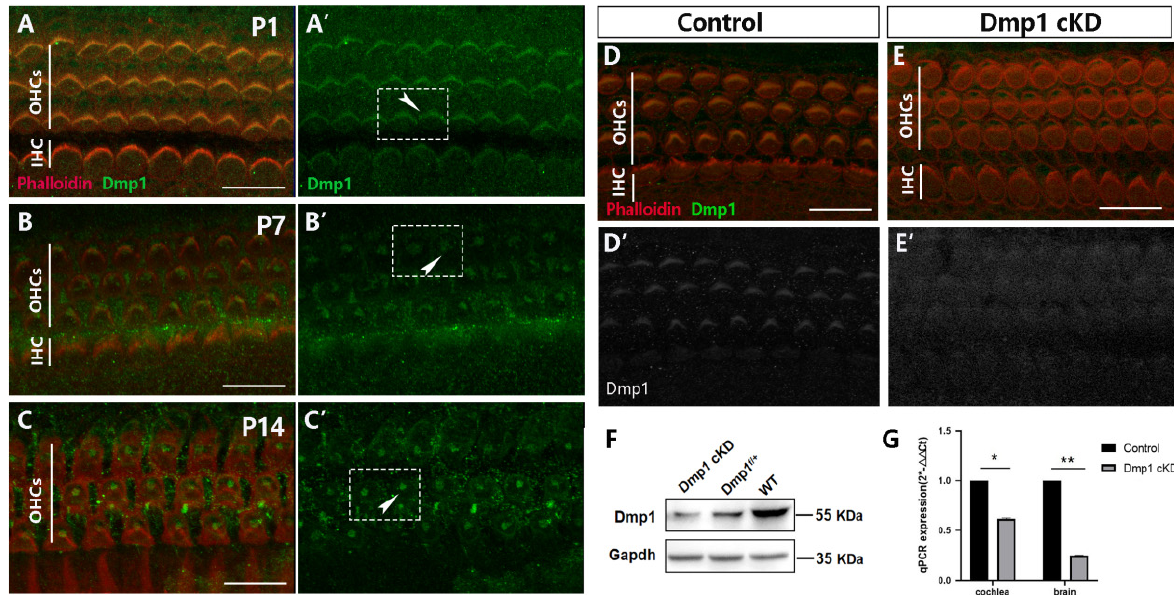
Figure 1. Dmp1 was dynamically expressed in the developing cochlea and the signal of Dmp1 was significantly weaker in mutant mice. ( A – C ): Confocal images of HCs in the mid ‐ basal regions stained. Dmp1 staining (green) was singly showed in ( A’ – C’ ). Cell boundaries and hair bundles were labeled by using phalloidin staining (red). At P1, the Dmp1 expression coincided with the hair cell stereocilia bundles (arrowhead in A’ ). At P7 and P14, Dmp1 was gradually concentrated at the V ‐ shaped apex of stereocilia and became a cloud cluster (arrowheads in B’ , C’ ). ( D , E ): Efficiency of Dmp1 deletion shown by mid ‐ basal regions in P1 cochlea of Dmp1 cKD and control mice, Dmp1 staining (gray) was singly showed in ( D’ , E’ ). Dmp1 was still detected in HCs of Dmp1 cKD with a much lower signal than in the control. ( F ): Western blot analysis of Dmp1 protein expression. Gapdh was used as the reference protein. It was shown that Dmp1 protein expression (gray band) was significantly lower than Dmp1 flox/+ and WT mice. ( G ): Quantitative analysis of Dmp1 at RNA level by qPCR. Dmp1 RNA expression was significantly reduced in the cochlea and brain tissues of mutant mice. Error bars represented the standard deviation and the statistical significance was assessed using a t -test. * p < 0.05; ** p < 0.01 (n = 3 each). Scale bars: 10 µ m. (See Figures S4–S9 for original Western blot